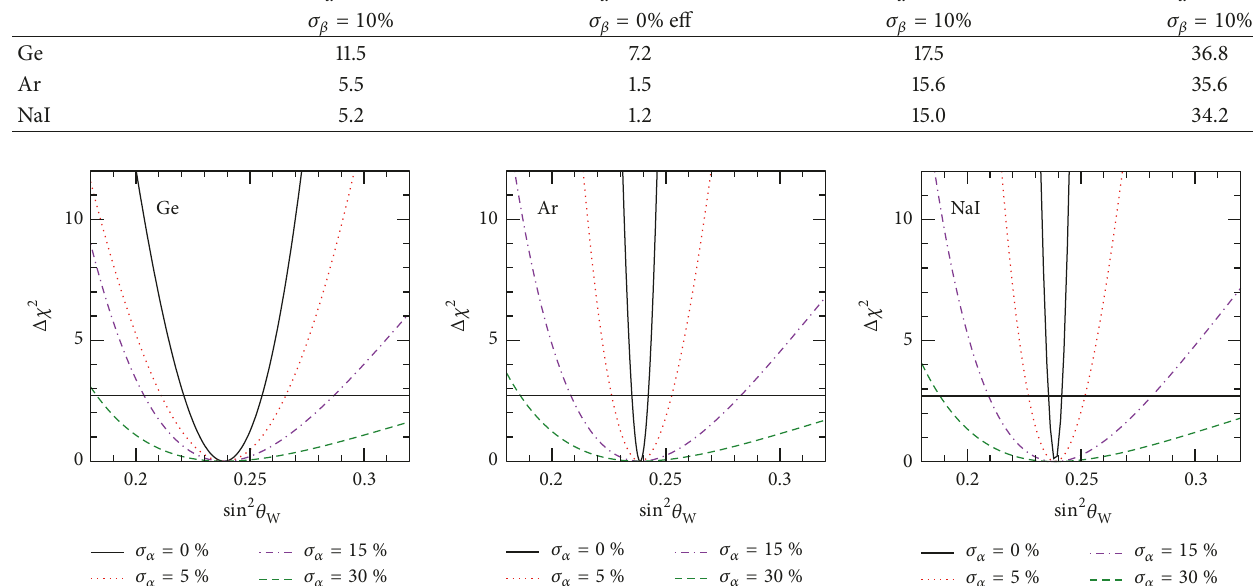
Figure 2: Expected sensitivity to sin 2 𝜃 𝑊 for the different detectors under consideration: Germanium, Argon, and NaI, respectively. The different curves are for the ideal case of 𝜎 𝛼 = 0 % with 100 % efficiency and a background error of 𝜎 𝛽 = 0 % (solid), for 𝜎 𝛼 = 5 % with 50 % efficiency and a background error of 𝜎 𝛽 = 10 % (dotted), for 𝜎 𝛼 = 15 % with 100 % efficiency and a background error of 𝜎 𝛽 = 10 % (dashed- dotted), and 𝜎 𝛼 = 30 % with 100 % efficiency and a background error of 𝜎 𝛽 = 10 % (dashed); see Table 2 and text for details. The horizontal line indicates the 90 %